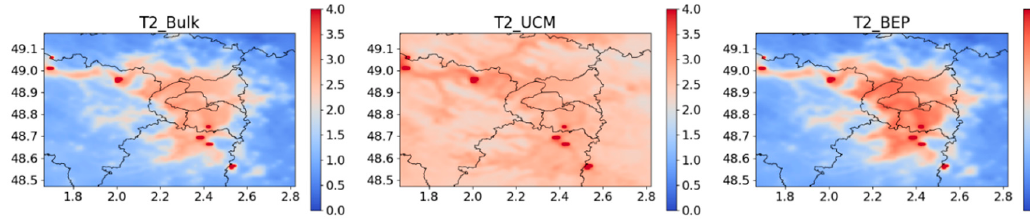
Figure 5. Maps of the mean 2 m temperature ( ◦ C) over the period from 27th November to 4th December.